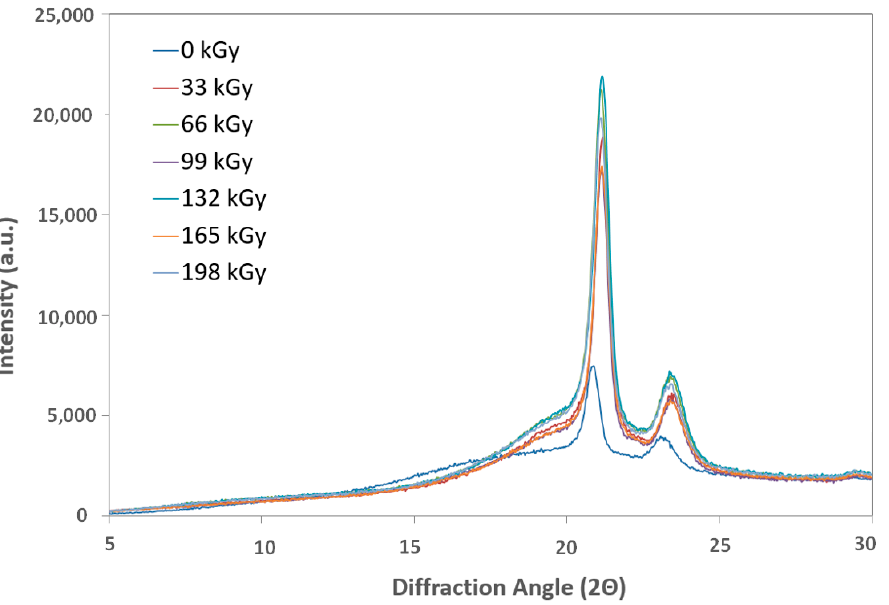
Figure 19. X-ray diffraction of irradiated LDPE. Figure 19. X-ray di ff raction of irradiated